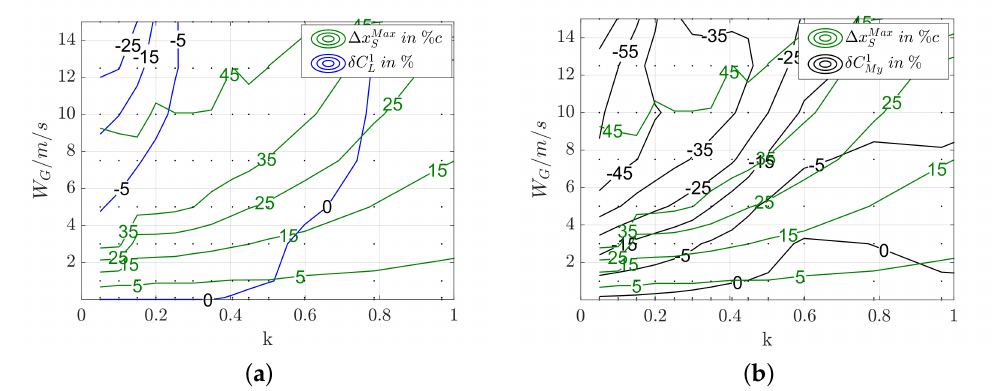
Figure 21. Harmonic deviation of lift and moment in comparison to the maximum shock motion at Mach 0.70. (grey dots denote the computed test cases). ( a ) δ C 1